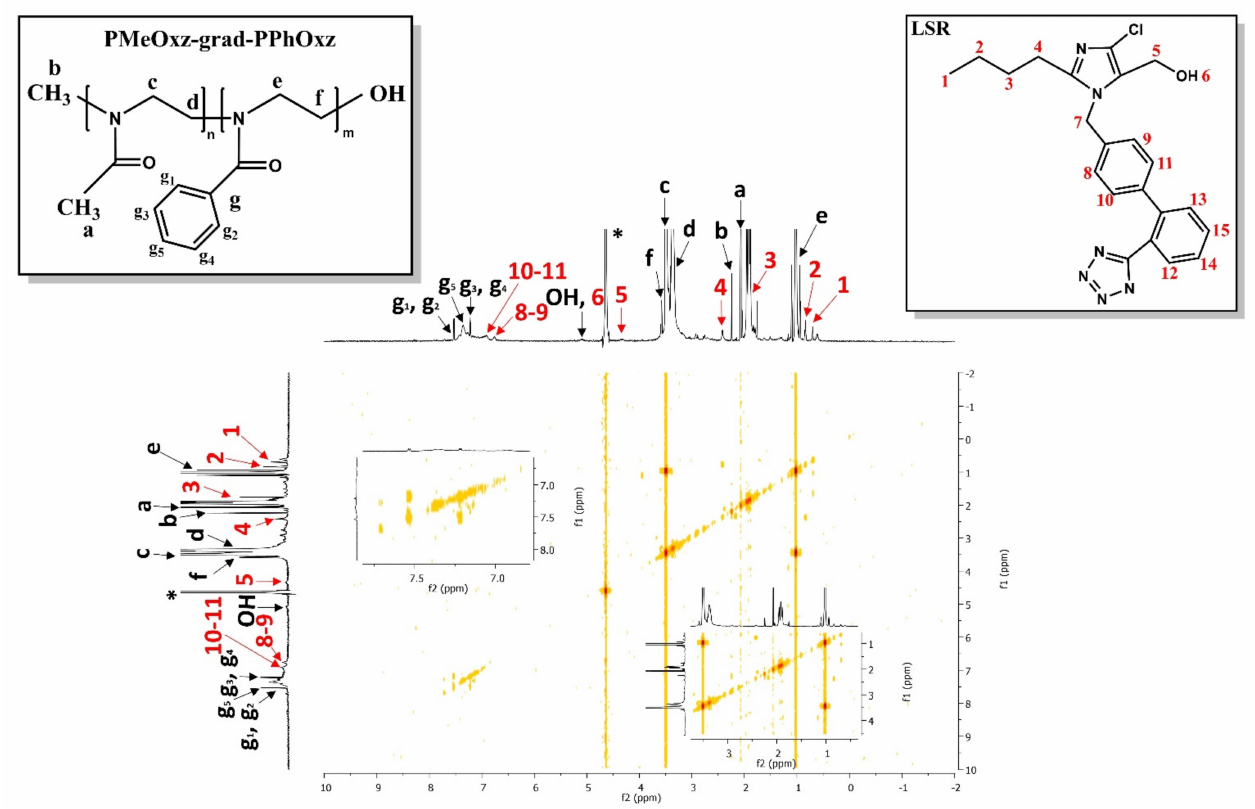
Figure 8. 2D-COSY spectrum of PMeOxz 72 -grad-PPhOxz 28 + 50% LSR nanocarriers in D 2 O solutions, where the black letters (a–g) denote the protons of the copolymer structure, the red letters point to the LSR peaks and the symbol * refers to the solvent D 2